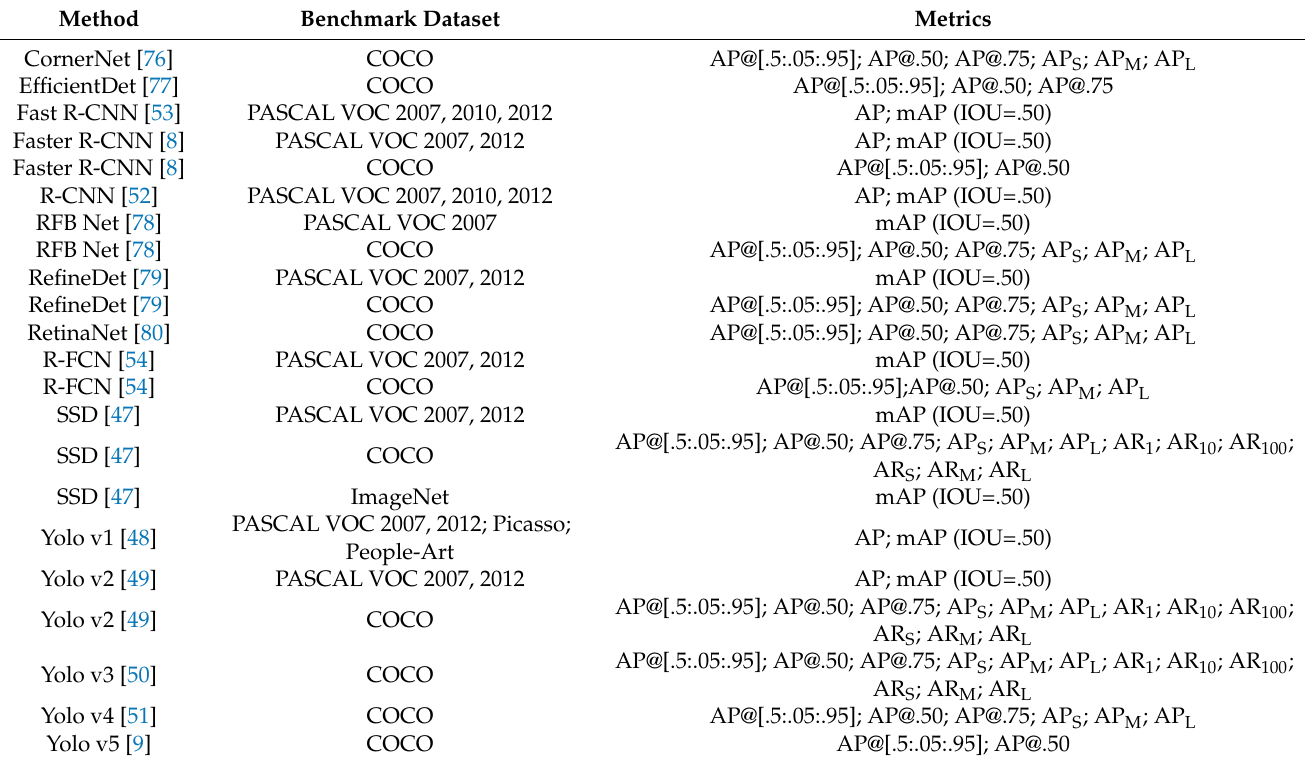
Table 2. Popular object detection methods along with the datasets and metrics used to report their results. Method Benchmark Dataset